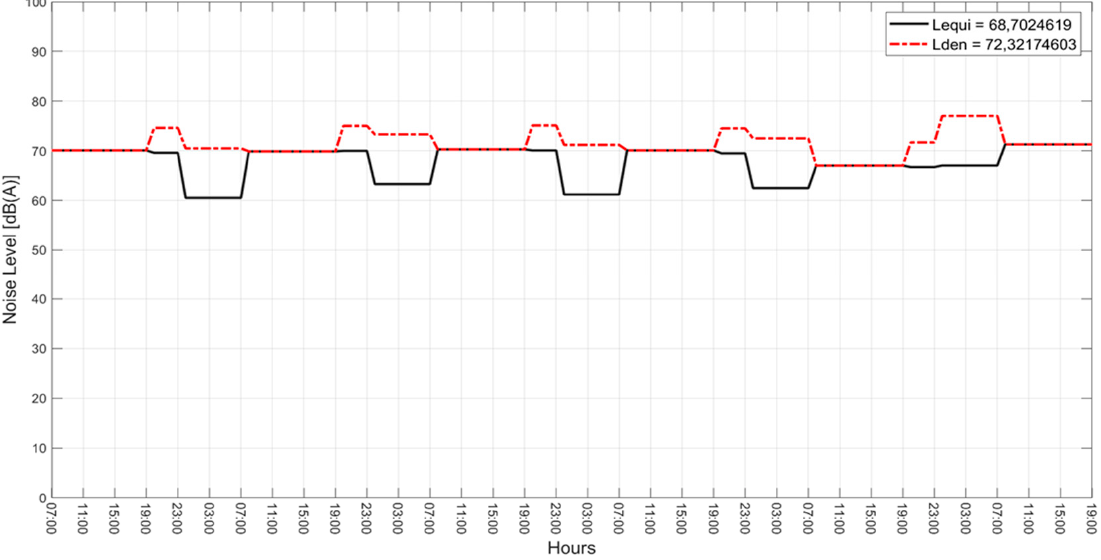
Figure 8. The equivalent noise level (L eq ) per hour measured and the day-evening-night noise level (L den ) in the CH ICU.